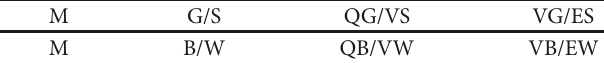
Step 4. Aggregate the EVs of all individuals into overall